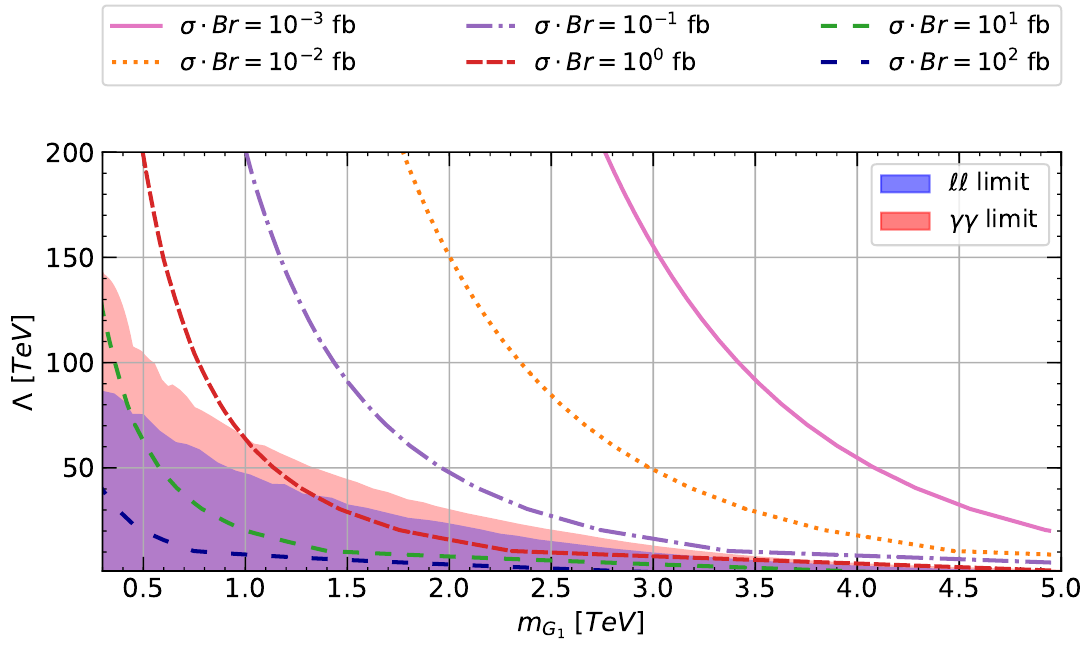
p Figure 7 . The exclusion region in the ( m s = 13 TeV and G 1 ; (cid:3)) plane at the LHC Run II with 36 fb (cid:0) 1 through resonant production of KK-graviton eventually decaying into leptons (light blue) and photons (light red), from refs. [47] and [48]. The dashed lines correspond to the functional relation between (cid:3) and m G for values of (cid:27) ( p p ! G 1 ) (cid:2) BR( G 1 ! ‘ ‘ ) ranging from 10 2 fb (bottom 1 line) to 10 (cid:0) 3 fb (top line) as in the